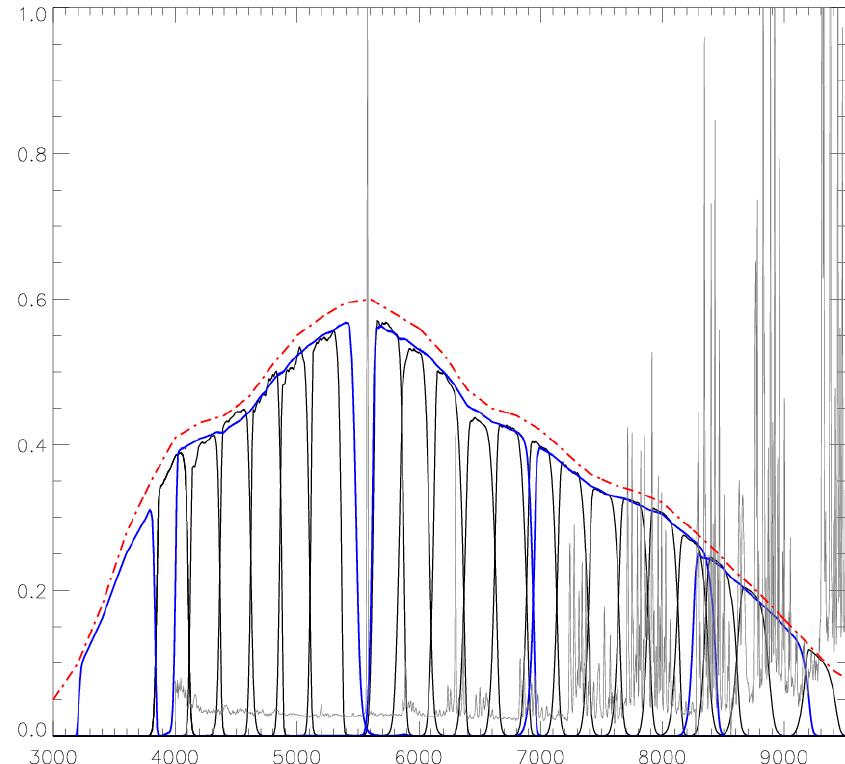
Figure 5. Transmission of broadband (blue lines) and medium-band filters (black lines), taking into account the quantum efficiency of the detector (red dot-dash line). With the dash line, we illustrate a typical night sky spectrum. Filters were measured at laboratory with F/2 beam, corresponding to the focal ratio of the 1-m telescope.